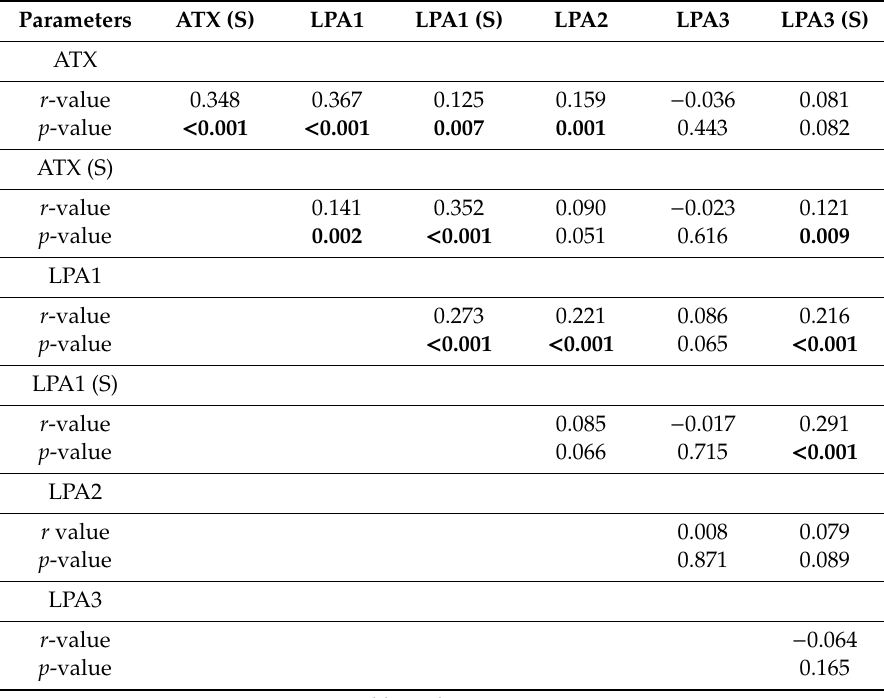
Table 4. Correlation among the expression of ATX-LPA signaling-related proteins.